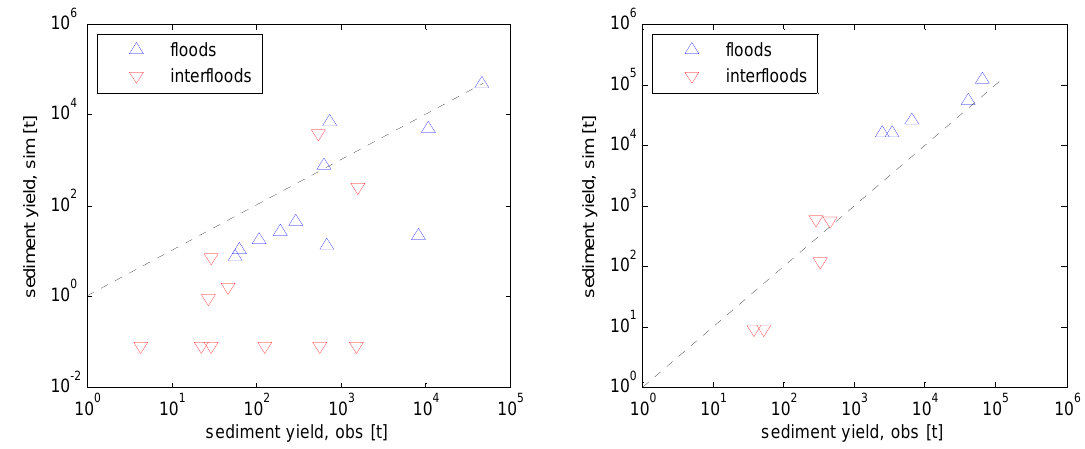
Figure 6: Flood-based sediment yield (observed vs. modelled) for the Villacarli Fig. 6. Flood-based sediment yield (observed vs. modelled) for the Villacarli (11 September 2006–4 January 2007, right) badlands and the Is´abena catchment (15 September 2006–29 January 2007, left). (2006/09/11-2007/01/04, right) badlands and the Isábena catchment (2006/09/15- Table 7. Comparison of observed and modelled transient riverbed storage data with sediment fluxes of the Isabena and Villacarli catchments. 2007/01/29, left). Zero values are plotted as 10 -1 because of the log-scale Landscape compartment